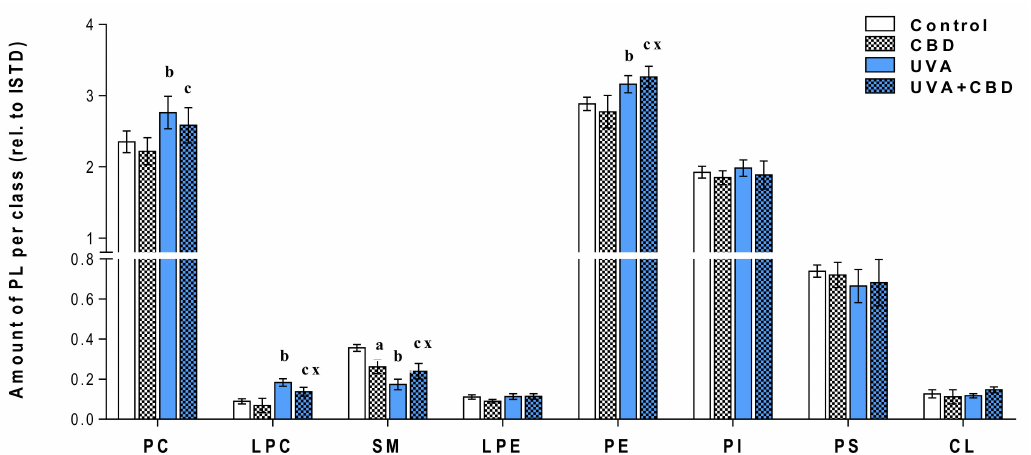
Figure 3. Changes in relative phospholipid content related to the internal standard of each phospholipid class within each class in keratinocytes isolated from the skin of control (Control) and UVA-irradiated rats (increasing doses from 0.5 to 5 J / cm 2 for 4 weeks). These cells have not been treated (Control and UVA) or treated with CBD (CBD and UVA + CBD) (2.5 g CBD in 100 g petrolatum); values are mean ± SD,